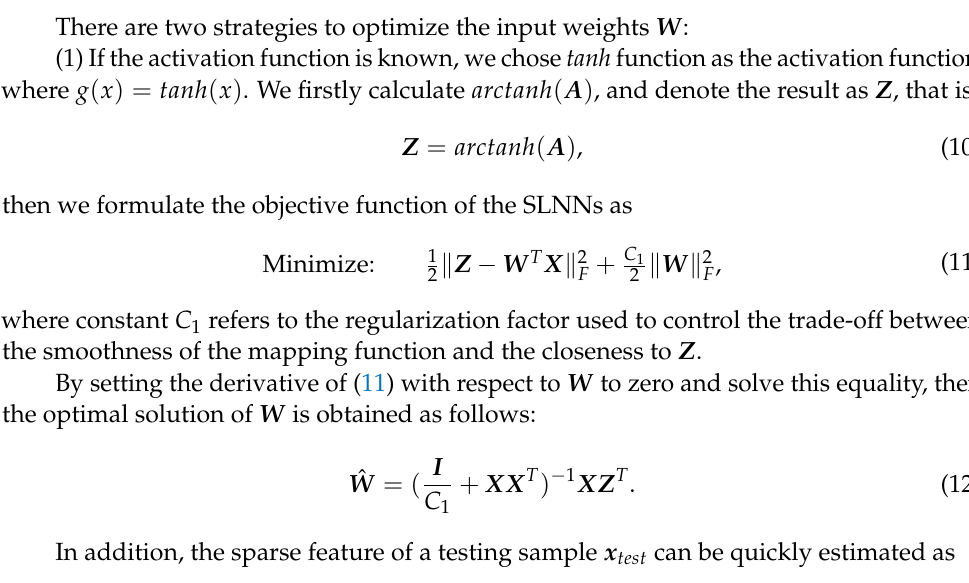
Figure 1. The schematic diagram of this proposed